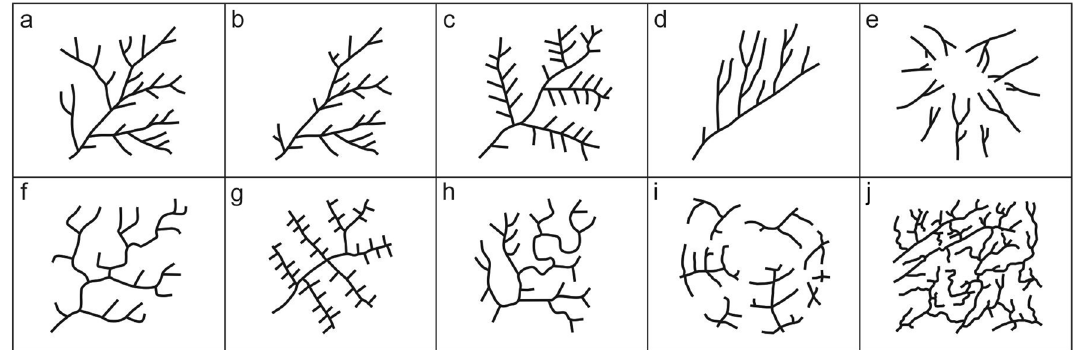
Figure 1. Main patterns of drainage networks: ( a ) dendritic; ( b ) sub-dendritic; ( c ) pinnate; ( d ) parallel; ( e ) radial; ( f ) rectangular; ( g ) trellis; ( h ) angular; ( i ) annular; ( j ) contorted (after 15,16 ). Hereinafter ( a )–( c ) patterns are related to dendritic forms (D), ( d )–( j ) to non-dendritic ones